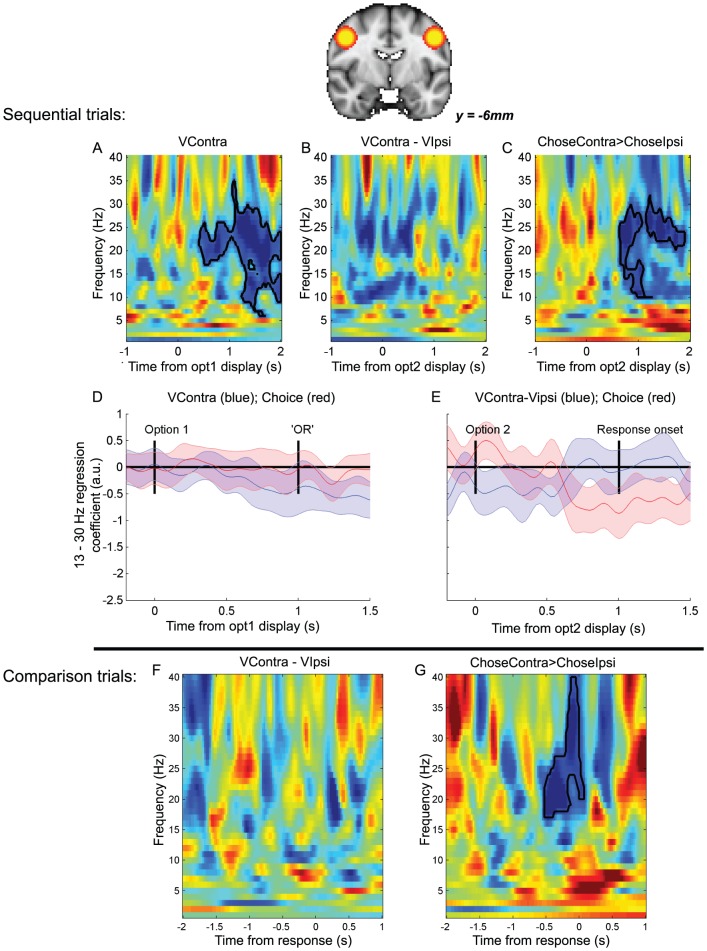
Lateral premotor cortex, similar to primary motor cortex, shows ‘action-space’ value followed by choice signals during sequential trials (A–E), and choice signal but no value signal during comparison trials (F–G).
Parts A–E are equivalent to parts B–F of

figure 2
. (A) Correlates of the value of option 1 at time of option 1 presentation, in hemisphere contralateral to option presentation. Color represents T-statistic; bordered areas reflect significant clusters (cluster-corrected P<0.05; permutation test). (B) Correlates of the value difference between the options contralateral and ipsilateral to the hemisphere, at the time of option 2 presentation. (C) Contrast of trials on which the chosen option is contralateral vs. ipsilateral to the hemisphere, at the time of option 2 presentation. (D) Timecourse of beta band correlates of value of contralateral option (blue and choice (red) at time of option 1 presentation. Lines represent mean +/− 95% confidence intervals across subjects. (Note that as 95% confidence intervals are plotted, rather than standard error of the mean (s.e.m.), error bars are ∼1.96 times wider than when plotting s.e.m.). (E) Timecourse of beta band correlates of value difference (blue) and choice (red) between options contralateral vs. ipsilateral to the hemisphere at time of option 2 presentation. Parts F–G are equivalent to parts B–C of

figure 4
. (F) Correlates of value difference between the options contralateral and ipsilateral to the hemisphere, timelocked to the response. (G) Contrast of trials on which chosen option was contralateral vs. ipsilateral to the hemisphere.